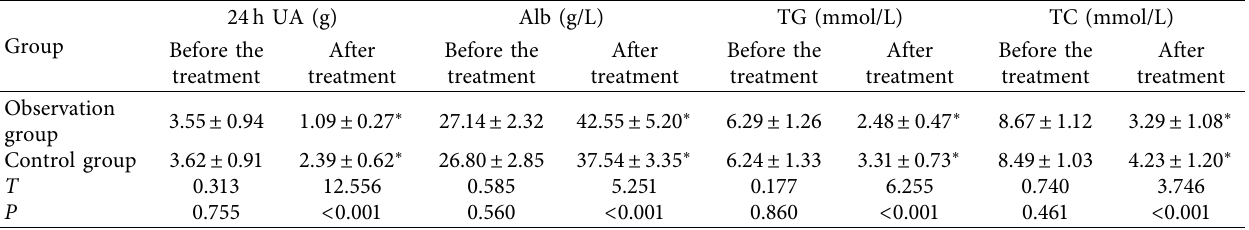
Group Before the